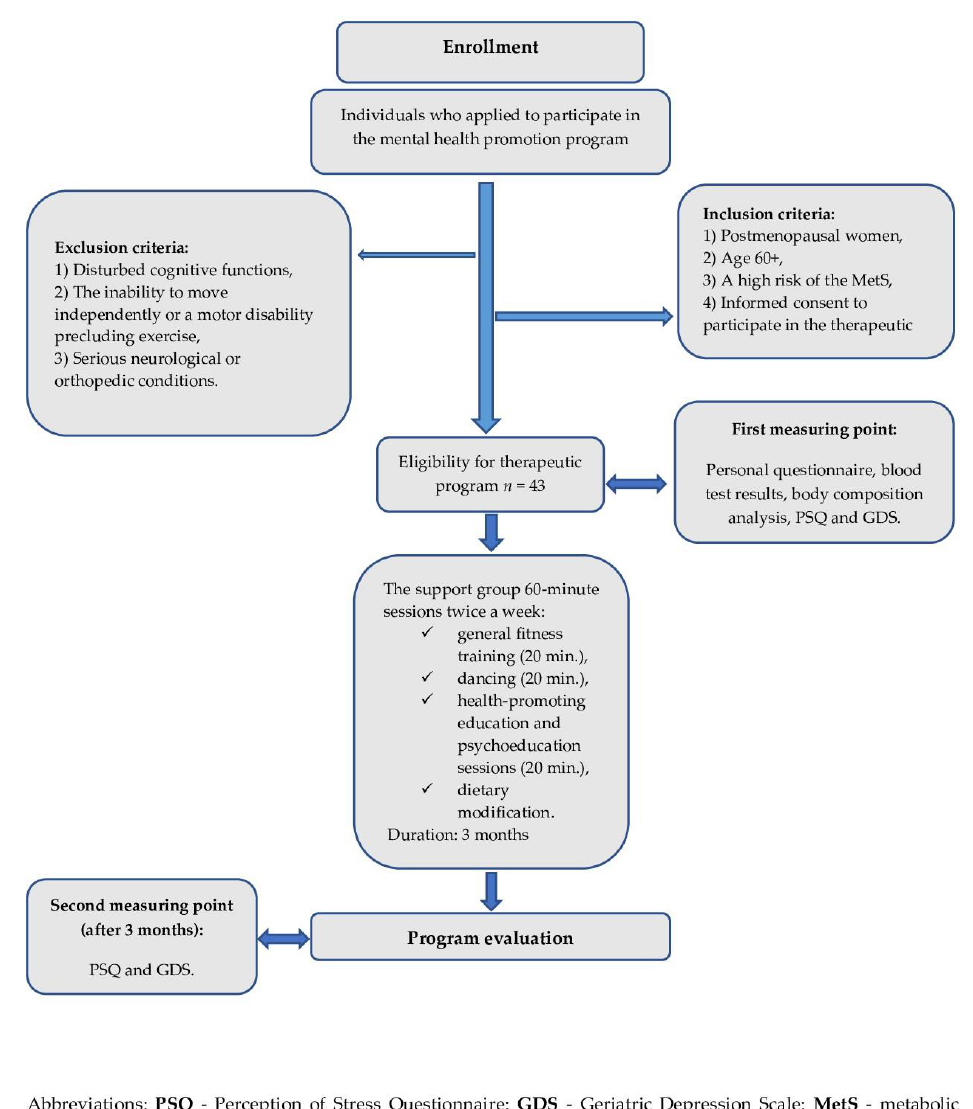
Figure 1. Flow chart of the recruitment process towards the study